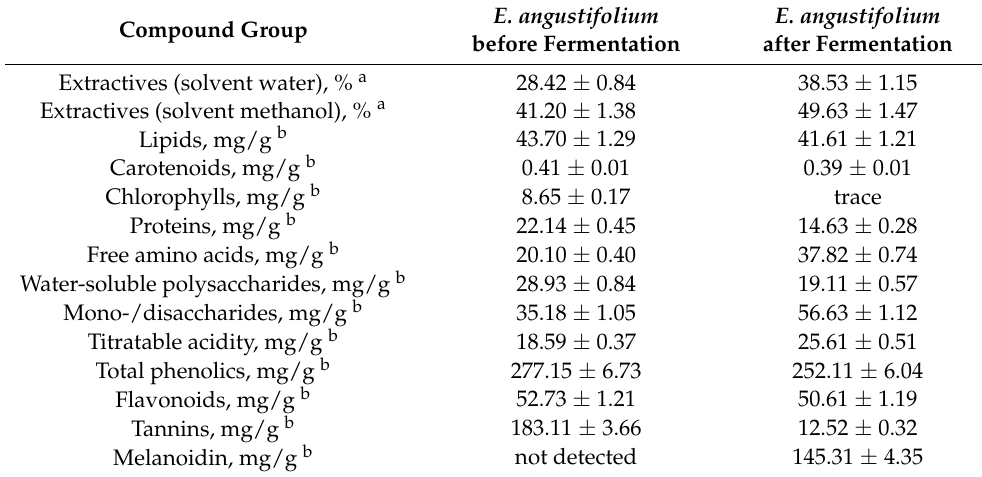
Table 1. The chemical composition of Epilobium angustifolium before and after fermentation ± S.D.